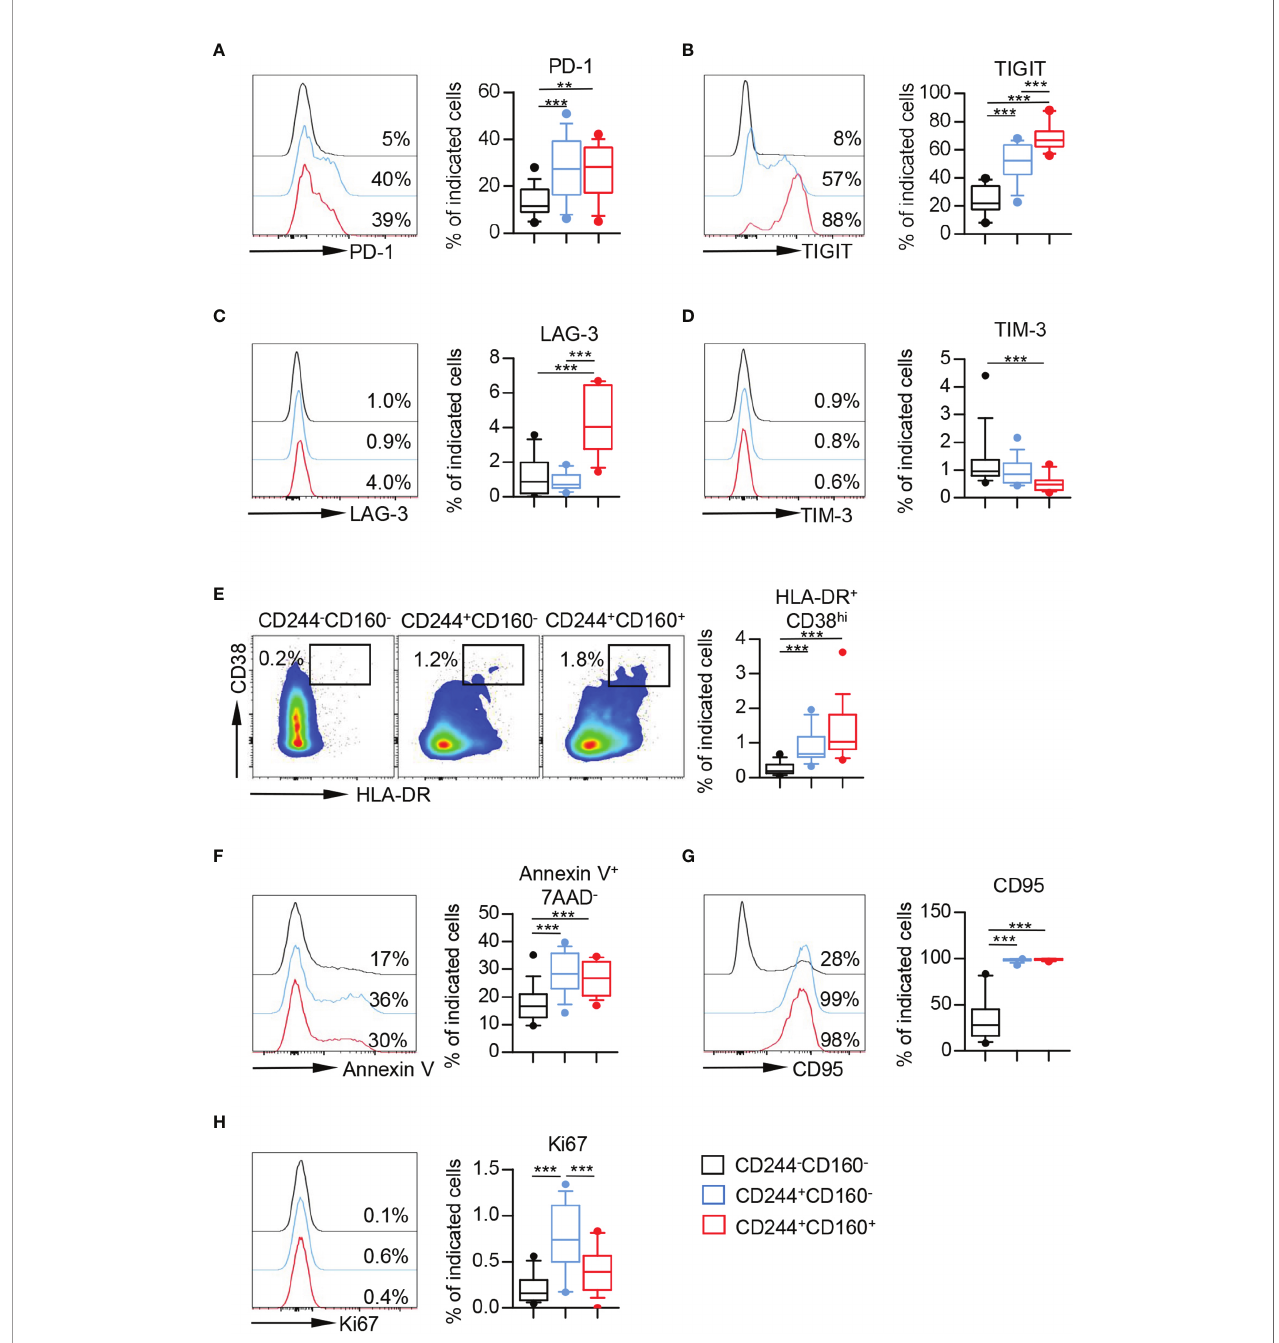
FIGURE 4 | CD244 + CD160 - and CD244 + CD160 + CD8 + T cells from the elderly partially displayed exhaustion. (A – E) Flow cytometry analysis of the expression of PD-1 (A) , TIGIT (B) , LAG-3 (C) , TIM-3 (D) , and percentage of HLA-DR + CD38 hi cells (E) on CD244 - CD160 - , CD244 + CD160 - and CD244 + CD160 + CD8 + T cells (n = 11-17). Representative histograms or fl ow data (left), and box plots (right) display the expression of the above receptors on CD244 - CD160 - , CD244 + CD160 - and CD244 + CD160 + cells (gated with CD8 + T cells). P values were obtained by repeated-measures ANOVA followed by Tukey ’ s multiple comparisons test (PD-1, TIGIT, and LAG-3) or Friedman ’ s test followed by Dunn ’ s multiple comparisons test (TIM-3 and HLA-DR + CD38 hi ). (F – H) Percentage of apoptotic cells (Annexin V + 7AAD - ) (F) and expression of CD95 (G) and Ki67 (H) on CD244 - CD160 - , CD244 + CD160 - and CD244 + CD160 + CD8 + T cells from the elderly (61-90 years old, n = 15-17). Representative histograms (left) and box plots (right) display the percentage of apoptotic cells (Annexin V + 7AAD - ) (F) and expression of CD95 (G) and Ki67 (H) on CD244 - CD160 - , CD244 + CD160 - and CD244 + CD160 + cells (gated with CD8 + T cells). P values were obtained by repeated-measures ANOVA followed by Tukey ’ s multiple comparisons test (Annexin V + 7AAD - and CD95) or Friedman ’ s test followed by Dunn ’ s multiple comparisons test (Ki67). ** P < 0.01, *** P <